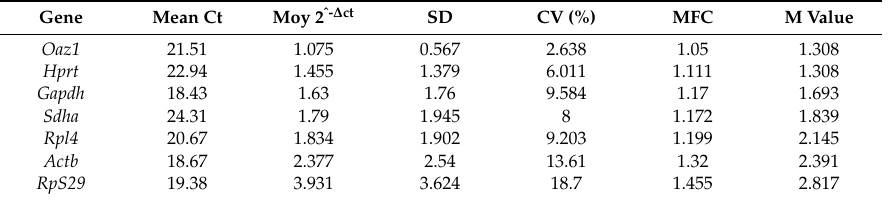
Table 3. Ranking of the seven tested housekeeping genes in isolated TECs, from the most to the least stable. Gene Mean Ct Moy 2 ˆ- ∆ ct SD CV (%)